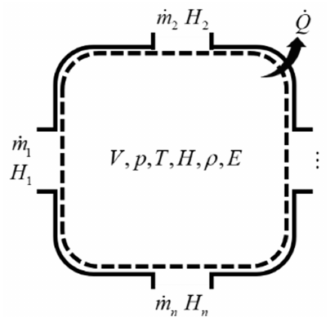
Figure 7. Schematic diagram of volume